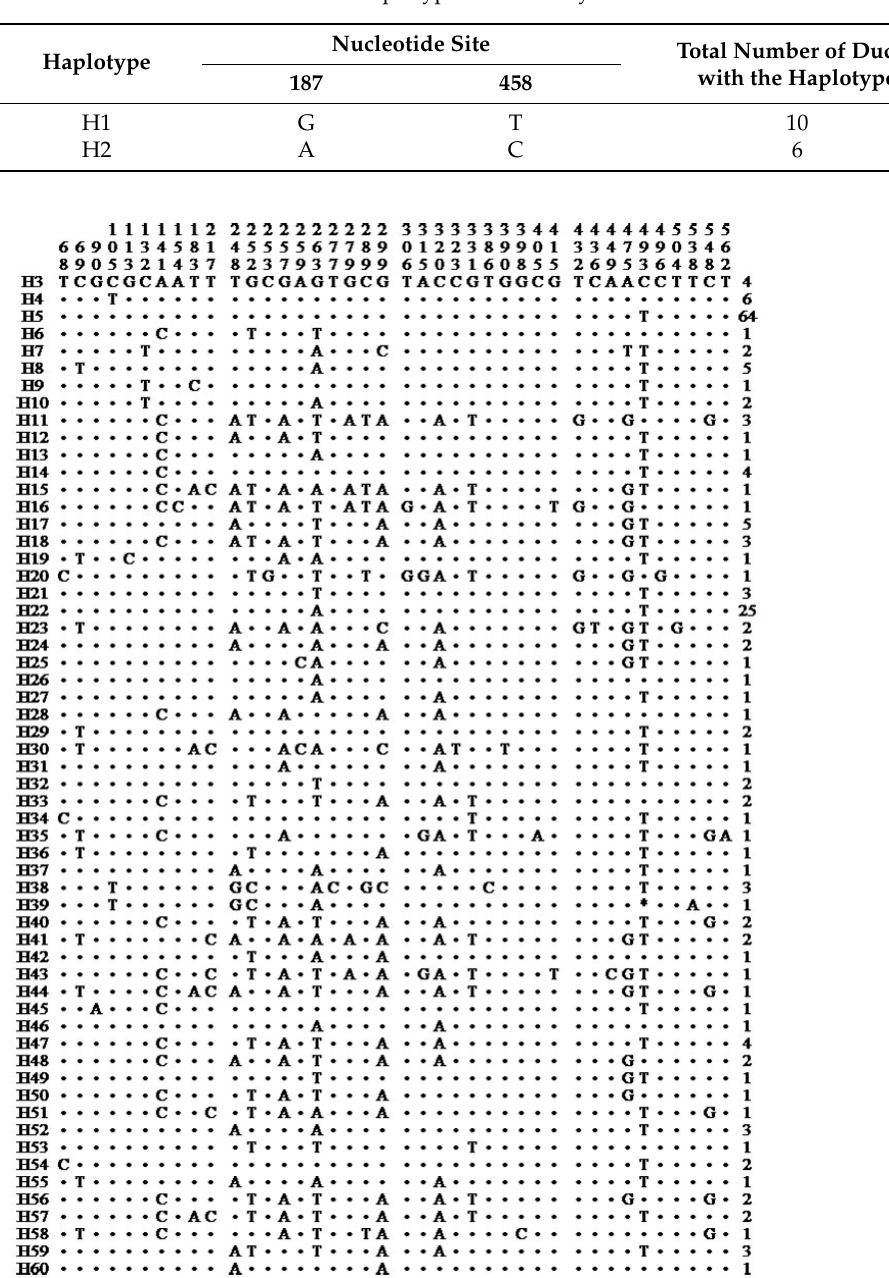
Figure 3. Variable sites in the mtDNA control region for haplotypes from domestic and Mallard ducks. · indicates identical nucleotides. Numbers on far right indicate the number of individual ducks with the haplotype. The average haplotype diversity (Hd), nucleotide difference (K), and nucleotide di- versity (Pi) in these 26 duck populations were 0.653, 3.104, and 0.005, respectively; the Zhongshan duck (ZS) had the highest (Hd = 0.929, K = 6.893, Pi = 0.0111), while Sichuan Ma duck (SC) and White Muscovy duck (BF) had the lowest (Hd = 0.000, K = 0.000, Pi =